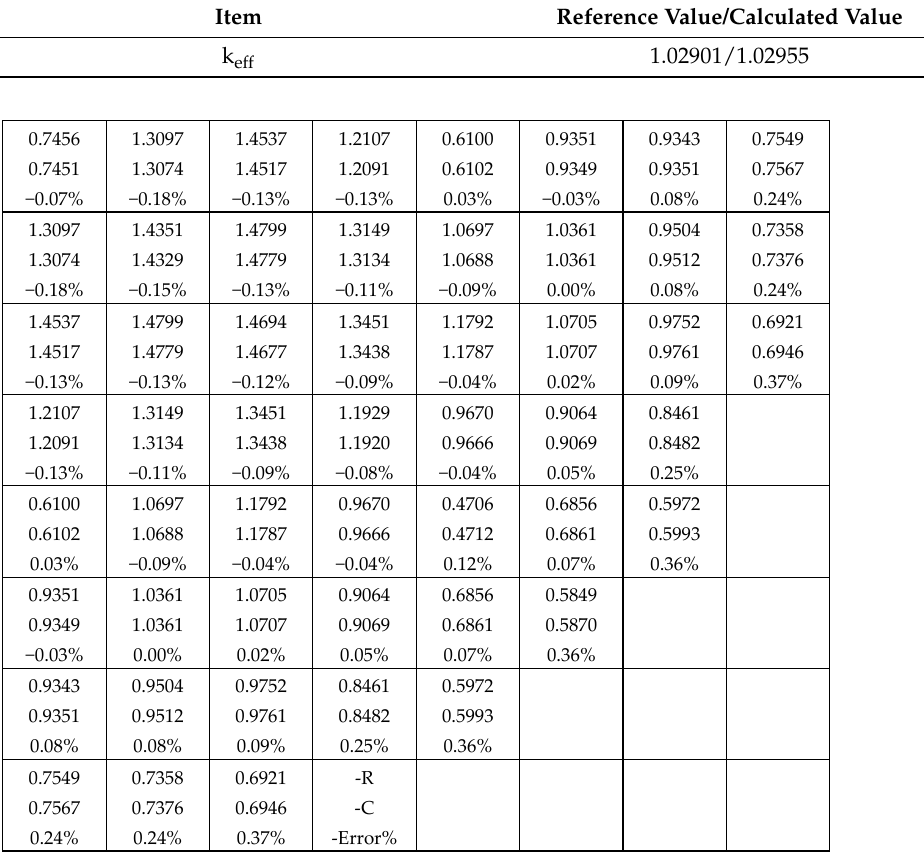
Figure 3. Calculation result of power distribution of IAEA-2D PWR benchmark example.